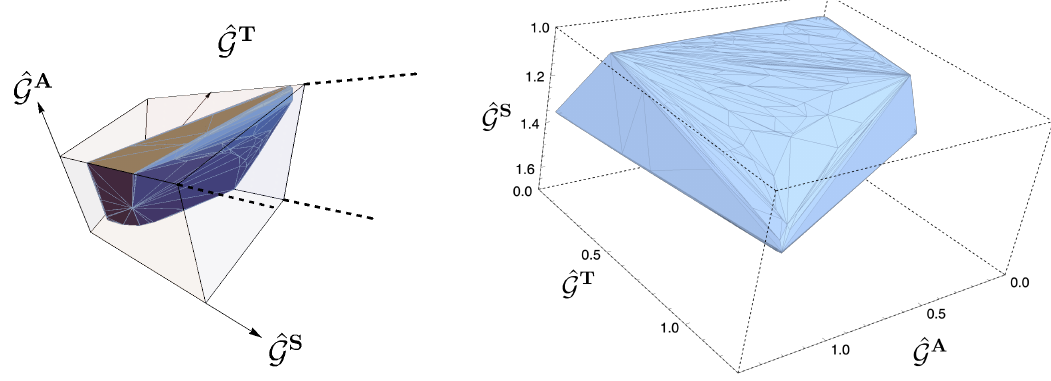
Figure 7 . Allowed values for charged O ( N ) correlators at z = 1 / 3 with N = 2 and with ∆ φ = 1 . On the left we show how the dark shaded allowed region is encased in the region of positive and monotonically growing correlators. On the right the two visible triangular facets of the solid correspond to solutions where ˆ G T or ˆ G A become constant. They meet at a corner point given by the solution ( B + F, 1 , 1) discussed in the main